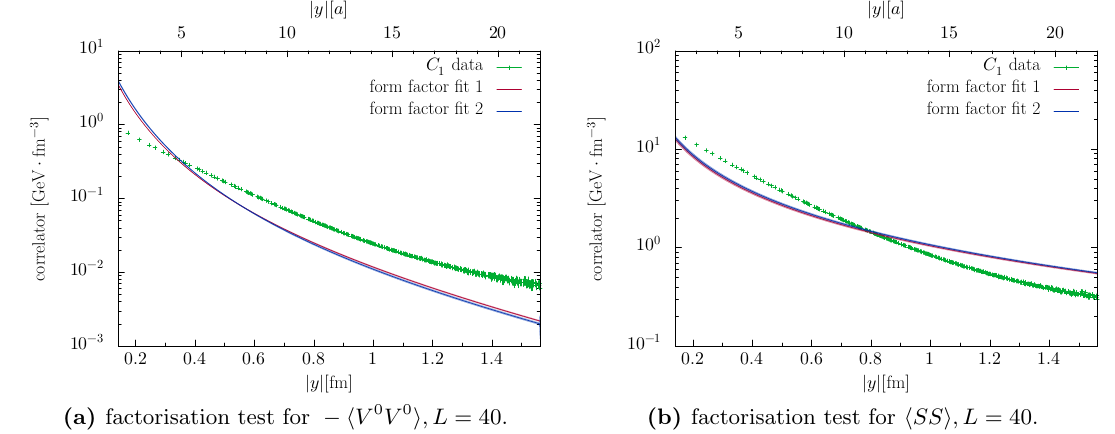
Figure 15. Test of the factorisation hypothesis for the two-current correlators The lattice data corresponds to l.h.s. of (5.3) in position space, and the curves with error bands are obtained by Fourier transforming the r.h.s. of (5.3) accordingly, using the form factor parameteri- sations speci(cid:12)ed in (5.8) and table